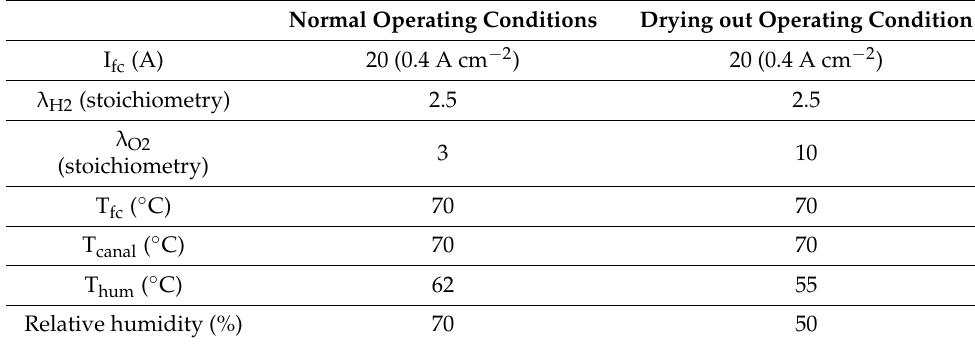
Table 1. Setting for normal and drying out conditions.